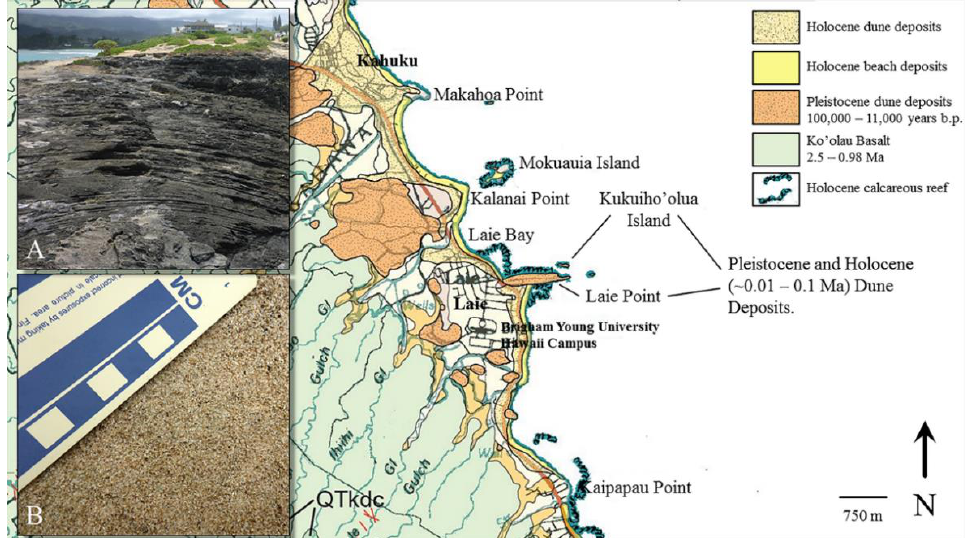
Figure 2. Geologic map of the Laie, Hawaii area, including Kukuiho’olua Island (after Sherrod et al., 2007). Compare to Figure 1. Insert ( A ) illustrates the cross-bedded nature of the Pleistocene-age sandstone that makes up Laie Point and Kukuiho’olua Island. Insert ( B ) is a close-up view of the sandstone.